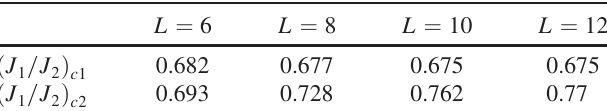
LEE, YOU, SACHDEV, and TABLE I. ð J 1 =J 2 Þ [ ð J 1 =J 2 Þ ] is the transition point between c 1 c 2 the DVBS and PVBS (PVBS and N´eel) phases. Transition points are extracted from the peak of the energy derivative at χ ¼ 4000 . At L ¼ 12 , the DMRG simulations do not converge for different initial states at χ ¼ 4000 , resulting in different transition points. Thus, the critical point is determined as the midpoint between two transition points obtained from the VBS- like and N´eel-like initial states.